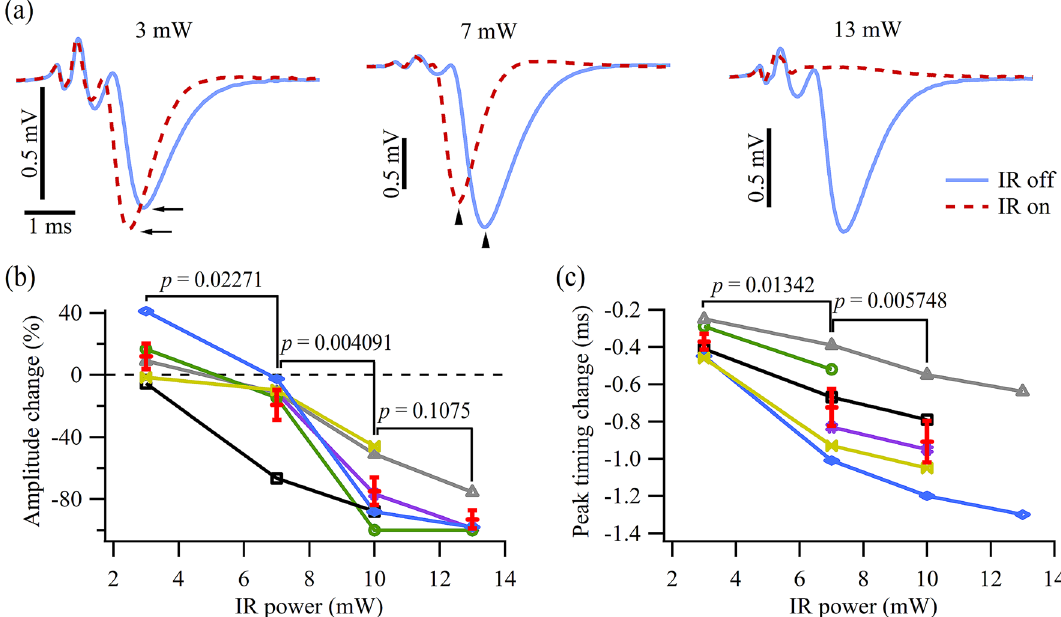
Figure 2. Modulation of the synaptic transmission by a single IR light pulse of different power levels. ( a ) Traces showing the EPSCs recorded from the same synapses in the absence (solid blue line) and presence of IR light illumination (dashed red line) using Protocol 1. Each trace was an average of 50 trials. All traces were recorded from the same terminal clusters. The three panels share the same horizontal scale bar on the bottom left. ( b ) Normalized EPSC amplitude changes (arrows in ( a )) caused by the IR light of four different pulse power levels. ( c ) Differences in the timing of the EPSC peak (arrowheads in ( a )) in response to the applied IR light pulse. Each type of symbols (colors) in ( b ) and ( c ) represents data obtained from one preparation dissected from an individual crayfish. The red bars in ( b ) and ( c ) indicate the mean ± SEM ( N =